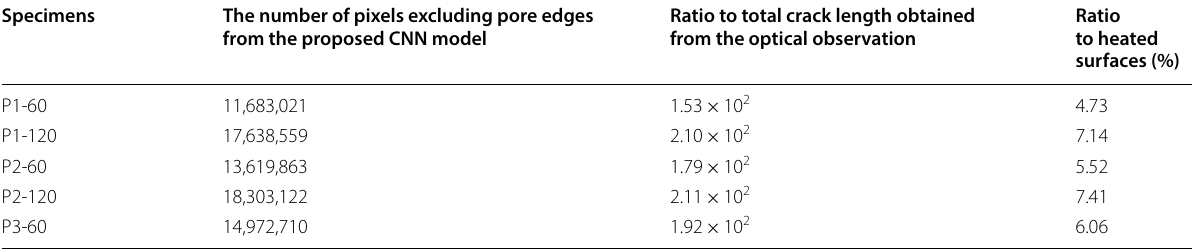
Table 6 CNN results excluding edges of pores.